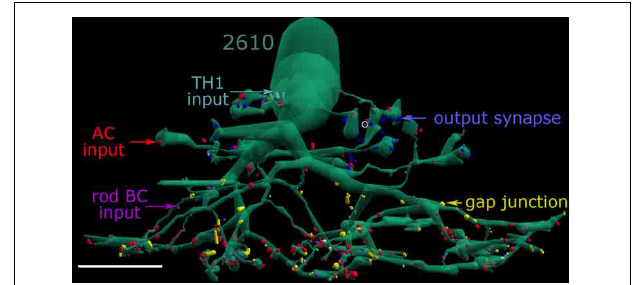
FIGURE 10 | AII cell partnerships. AII cell 2610 with its rod bipolar cell input (magenta), amacrine cell input synaptic input (red), coupling sites (yellow), TH1 cell input (cyan), and glycinergic synaptic output (blue) dimensionally mapped onto its surface. Small white dots are adherens junctions. A single visible OFF cone BC ribbon is marked with a white circle. Scale, 10 μ m.